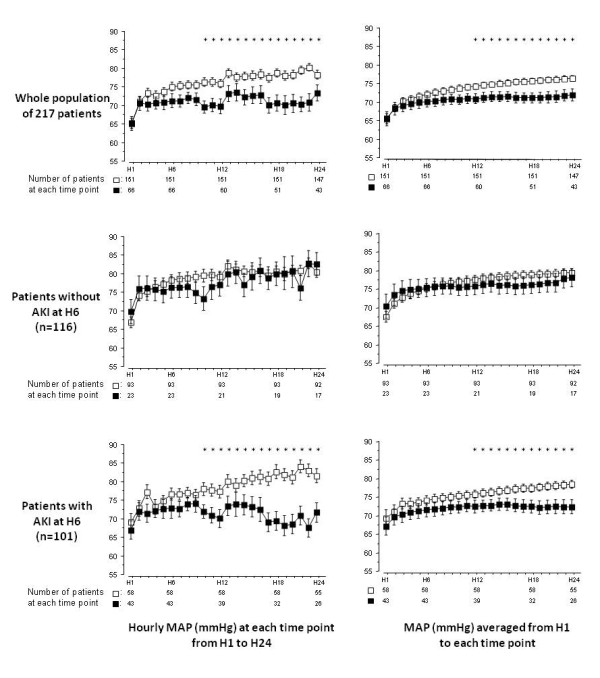
Evolution of mean arterial pressure (MAP) during the first 24 hours. The evolution of hourly MAP (left panels) and of MAP time-averaged MAP (right panels) compared between patients who will have acute kidney insufficiency (AKI) at H72 (black squares) and those who will not (open squares), is shown for the whole population (top panels), for the group of patients with no AKI at H6 (middle panels) and for the group of patients with AKI at H6 (bottom panels). The significant differences observed in MAP (from H10 to H24 for hourly MAP and from H12 to H24 for time-averaged MAP, as indicated by an asterisk upon each time point) between patients who will or will not have AKI at H72 in the whole population (top panels) were mainly due to the patients with AKI at H6 (bottom panels). Asterisks upon time points indicate a significant difference (P < 0.05) between patients who will have AKI at H72 (black squares) and those who will not (open squares) (post hoc comparison after analysis of variance). Error bars represent standard errors.